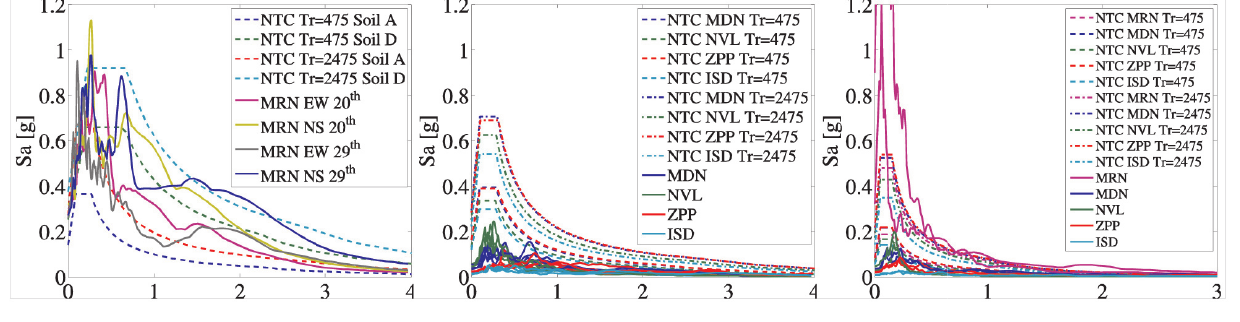
Figure 6. Comparison with code spectra for horizontal components of: MRN station (left), of the other four stations (center), and for the vertical com- ponents of all of the stations (right). Horizontal axis: always T (s). (Vertical component of MRN might be affected by instrumental error) [see Mirandola Earthquake Working Group